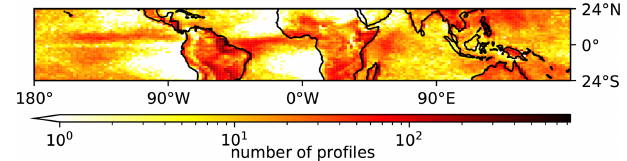
Figure 2. Heat map of grid columns that have been filtered based on CAPE and maximum shear. The heat map shows the number of profiles in each grid column that have been kept after applying both filters to the output of the 5 years of the